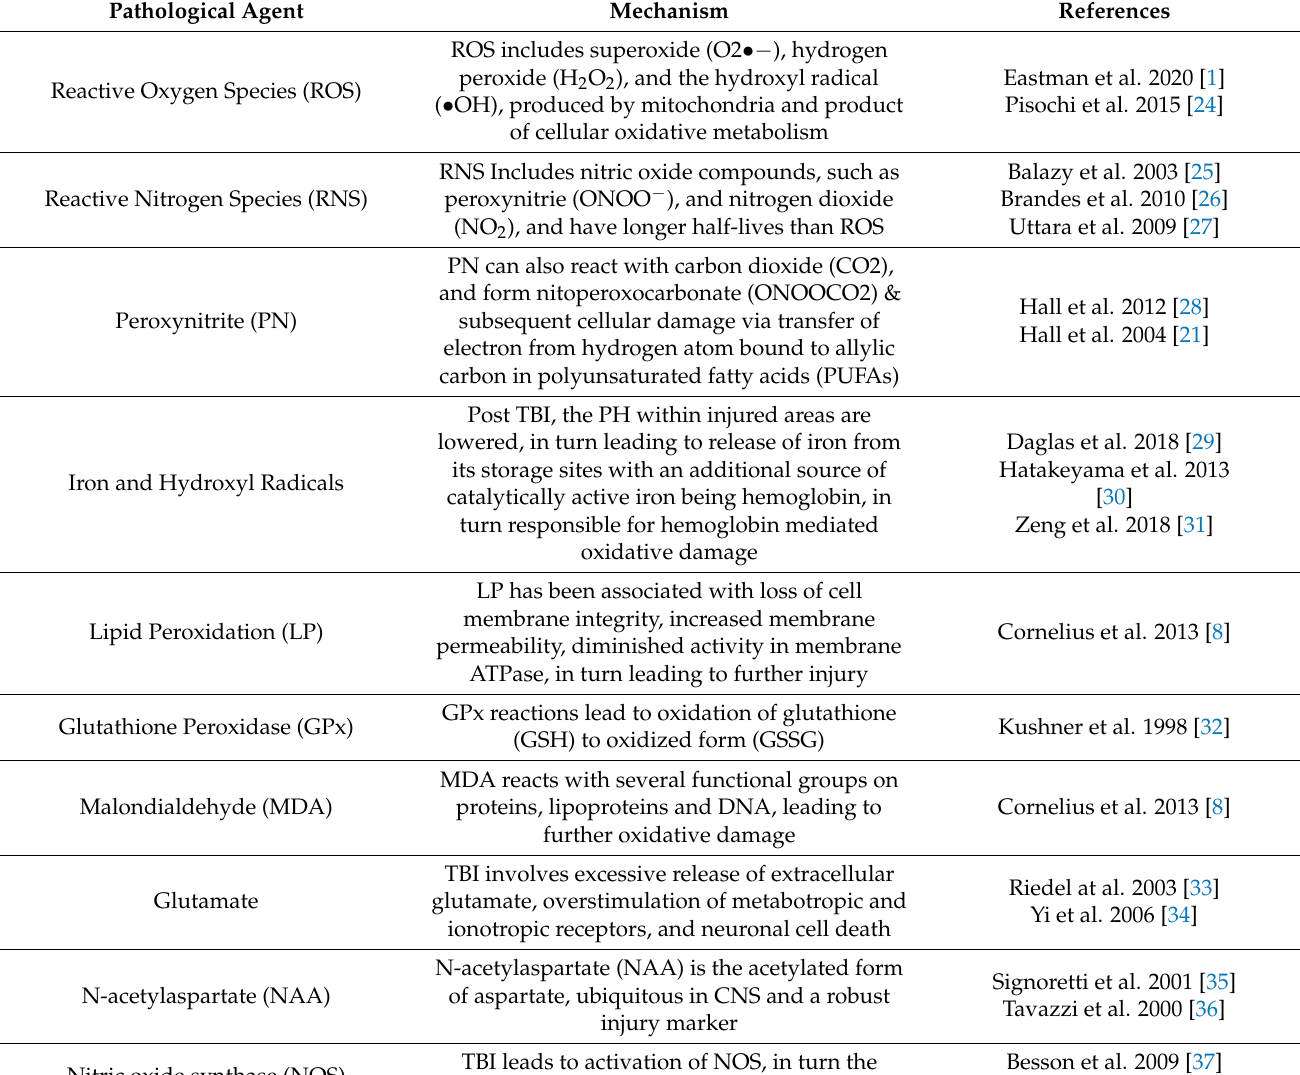
Table 1. Outlines the main pathological agents involved in TBI oxidative stress, and their correspond- ing proposed